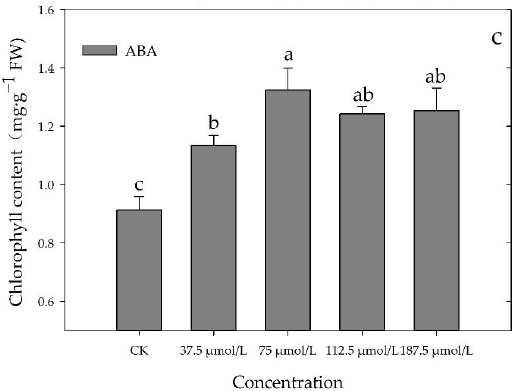
Figure 1. Effects of different concentrations of SA ( a ), 6-BA ( b ), or ABA ( c ) on chlorophyll content (Chl) of Rosa hybrida ‘Carolla’. CK: distilled water. Vertical bars mean standard errors ( n = 10). The values are described as means ± SD; different letters denote significant differences ( p < 0.05) according to Duncan’s multiple range tests.